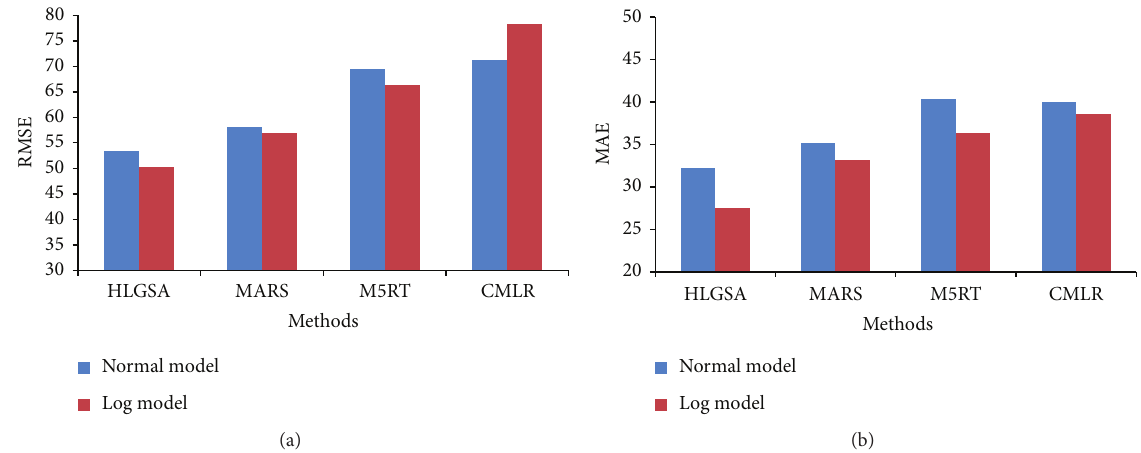
Figure 13: Comparison of overall errors of all log and normal models for Astore